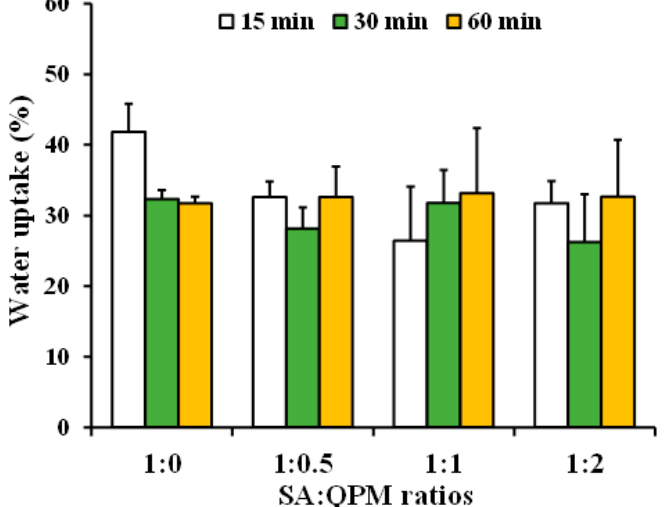
Figure 7. Water uptake of PPN-loaded CA-QPM gel beads at different SA:QPM ratios. Each value is the mean ± S.D., n = 3.